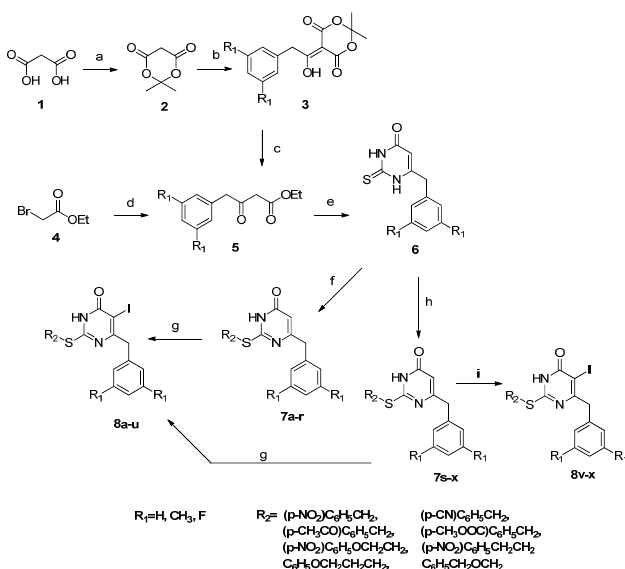
Scheme 1. Synthesis of Target Compounds 8a – x